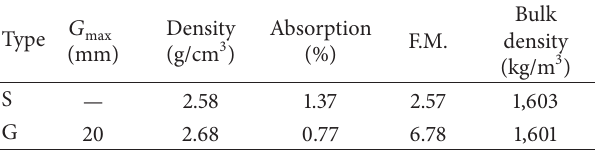
Table 2: Physical properties of aggregates.